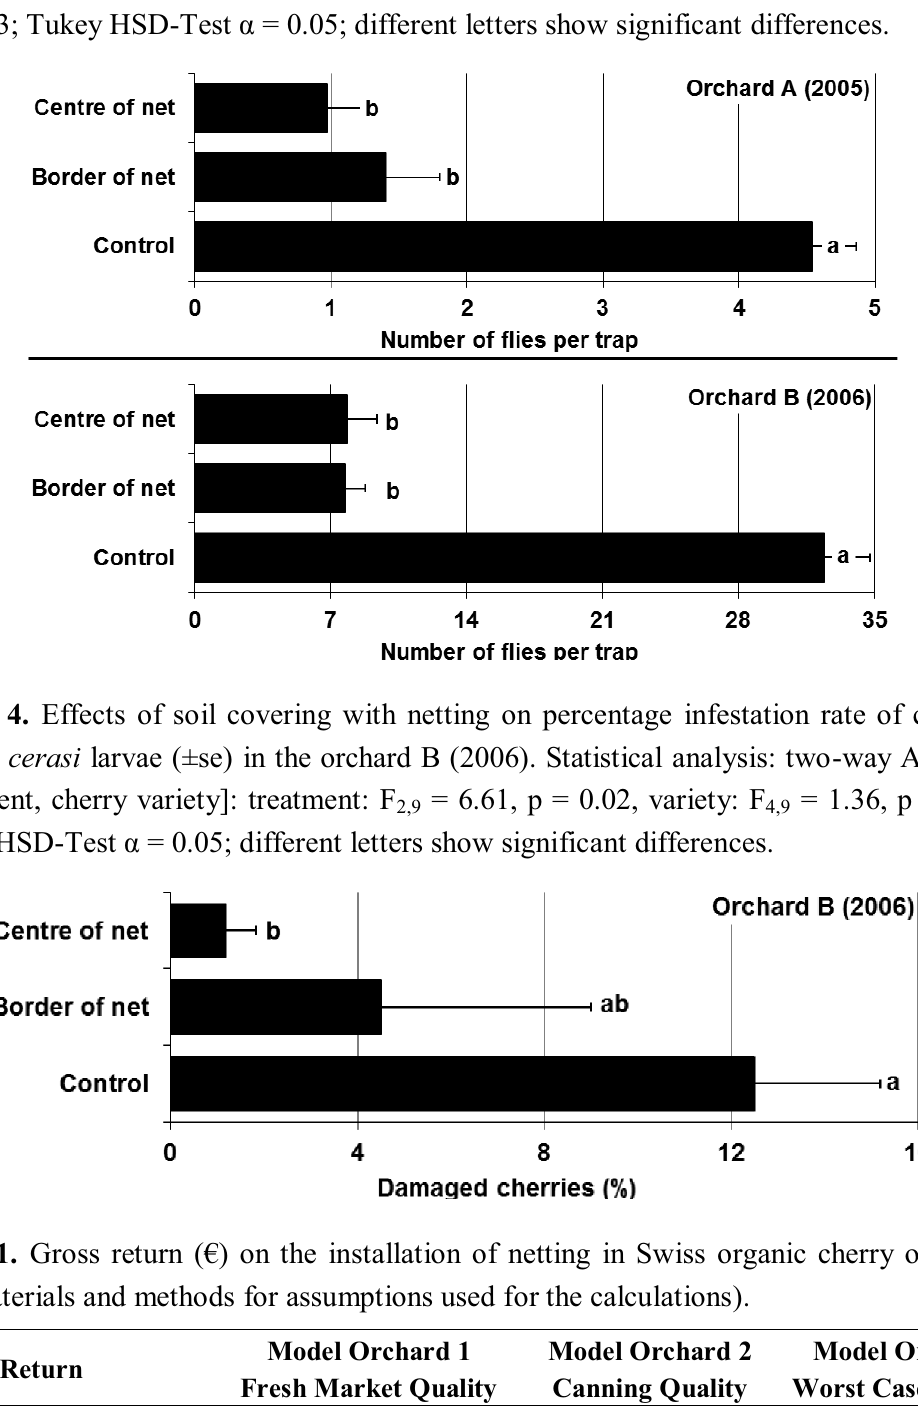
Figure 3. Effects of soil covering with netting on average number of R. cerasi (±se) on yellow sticky traps in orchard A (2005) and orchard B (2006). Statistical analysis: orchard A: one-way ANOVA: F = 34.99, p < 0.001; Orchard B: two-way ANOVA 2,12 [treatment, cherry variety]: treatment: F = 118.46, p < 0.001, variety: F = 4.70, 2,9 4,9